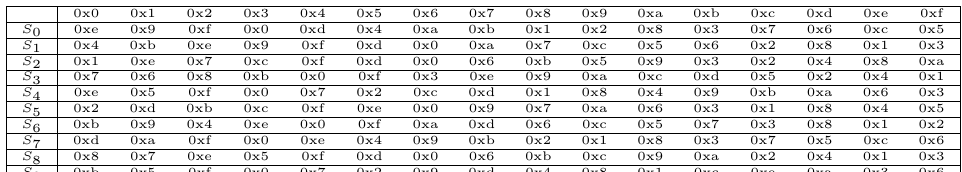
Table 5: The 10 Sboxes used in LBlock